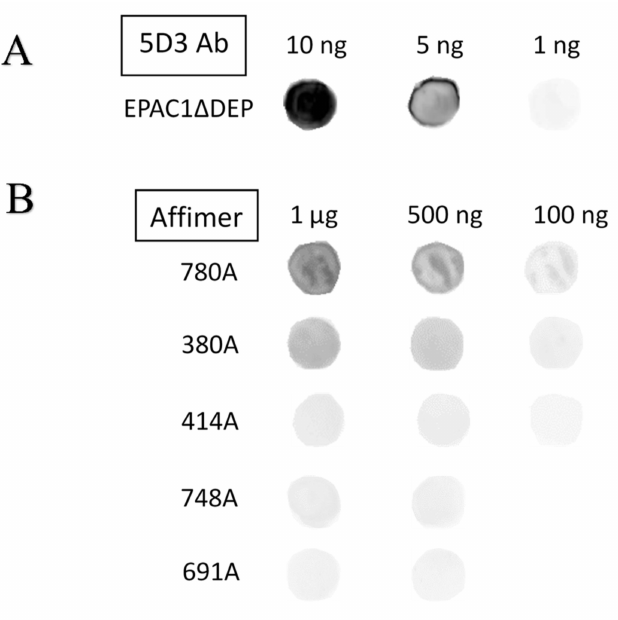
Figure 3. Dot blotting of anti-EPAC1 antibody and Affimer binding to recombinant EPAC1 ∆ DEP protein. Recombinant EPAC1 ∆ DEP protein was spotted onto nitrocellulose membranes as indicated. Membranes were then blocked for one hour in 5% ( w/v ) milk or BSA in TBST followed by two hours incubation with either ( A ) 4.5 nM of anti-EPAC1-antibody (mAb 5D3) in 5% ( w/v ) milk in TBST or ( B ) 45 nM of Affimer (780A, 380A, 414A, 691A and 748A) in 5% ( w/v ) in TBST. Membranes were then incubated for one hour with either anti-mouse IgG-HRP, for mAb 5D3, or anti-His-tag HRP, for Affimer, secondary antibodies. All incubations were performed at room temperature. Protein signals were detected by ECL and visualized by Fusion FX imaging software. The image is representative of an experiment carried out on three separate